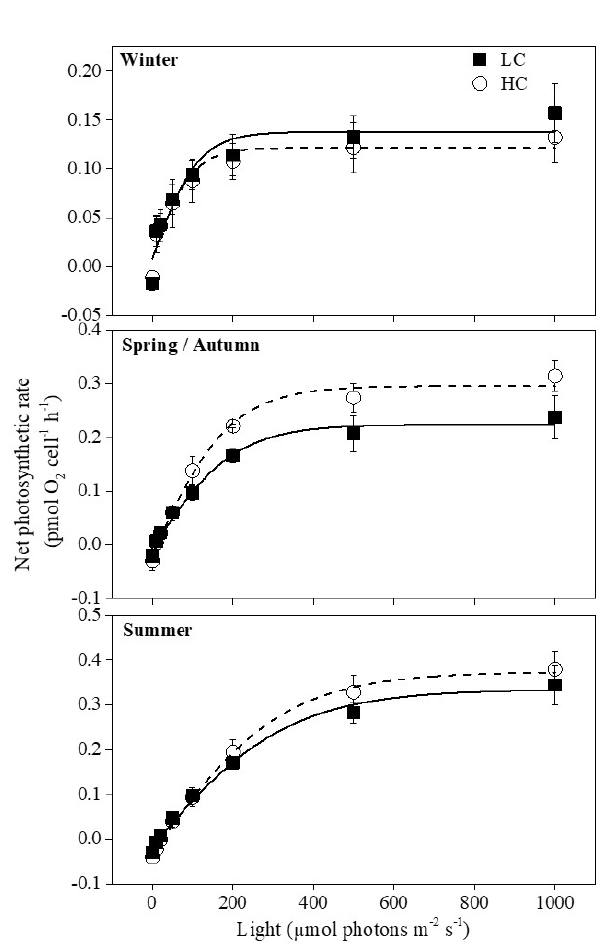
Figure 3. Photosynthesis–light curves ( P – I curves) of cells accli- mated to ambient and elevated p CO 2 in different seasons. The data are mean ± SD values of triplicate cultures ( n =